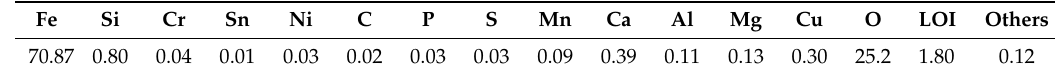
Table 3. Mill scale chemical composition, in wt. %.